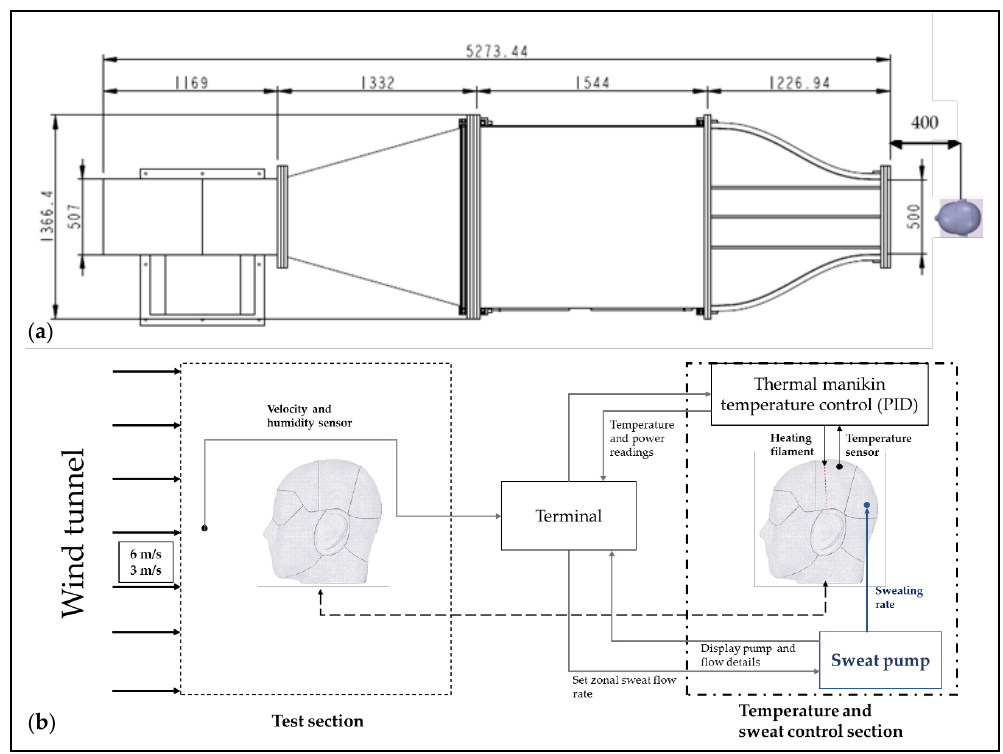
Figure 2. ( a ) Schematic of open-loop wind tunnel used for simulating tested velocities with thermal manikin; ( b ) schematic and process flow of convective and evaporative testing.